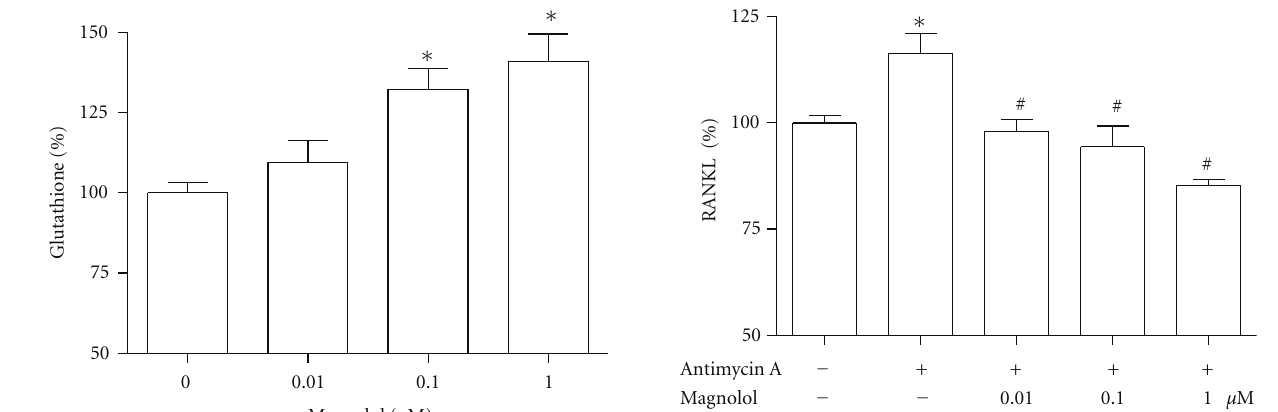
Figure 5: E ff ect of magnolol on the glutathione content of MC3T3- E1 cells. Data were expressed as a percentage of control. The control value for collagen content was 12.8 ± 0.305 nmole/mg. ∗ P < 0 . 05 compared with control.